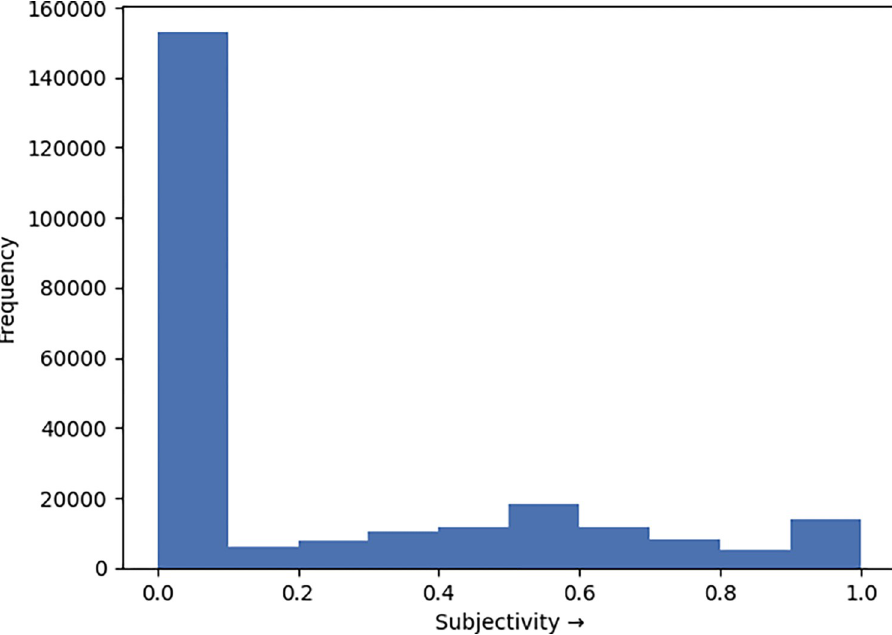
Fig 2. Objectivity/Subjectivity analysis of tweets. 0 represents complete objectivity, 1 represents complete subjectivity.